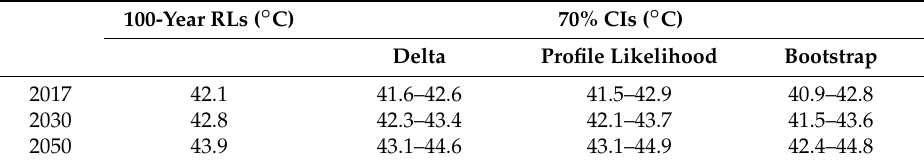
Table 2. Results of the conditional predictions (CPs) for the years 2017, 2030, and 2050.